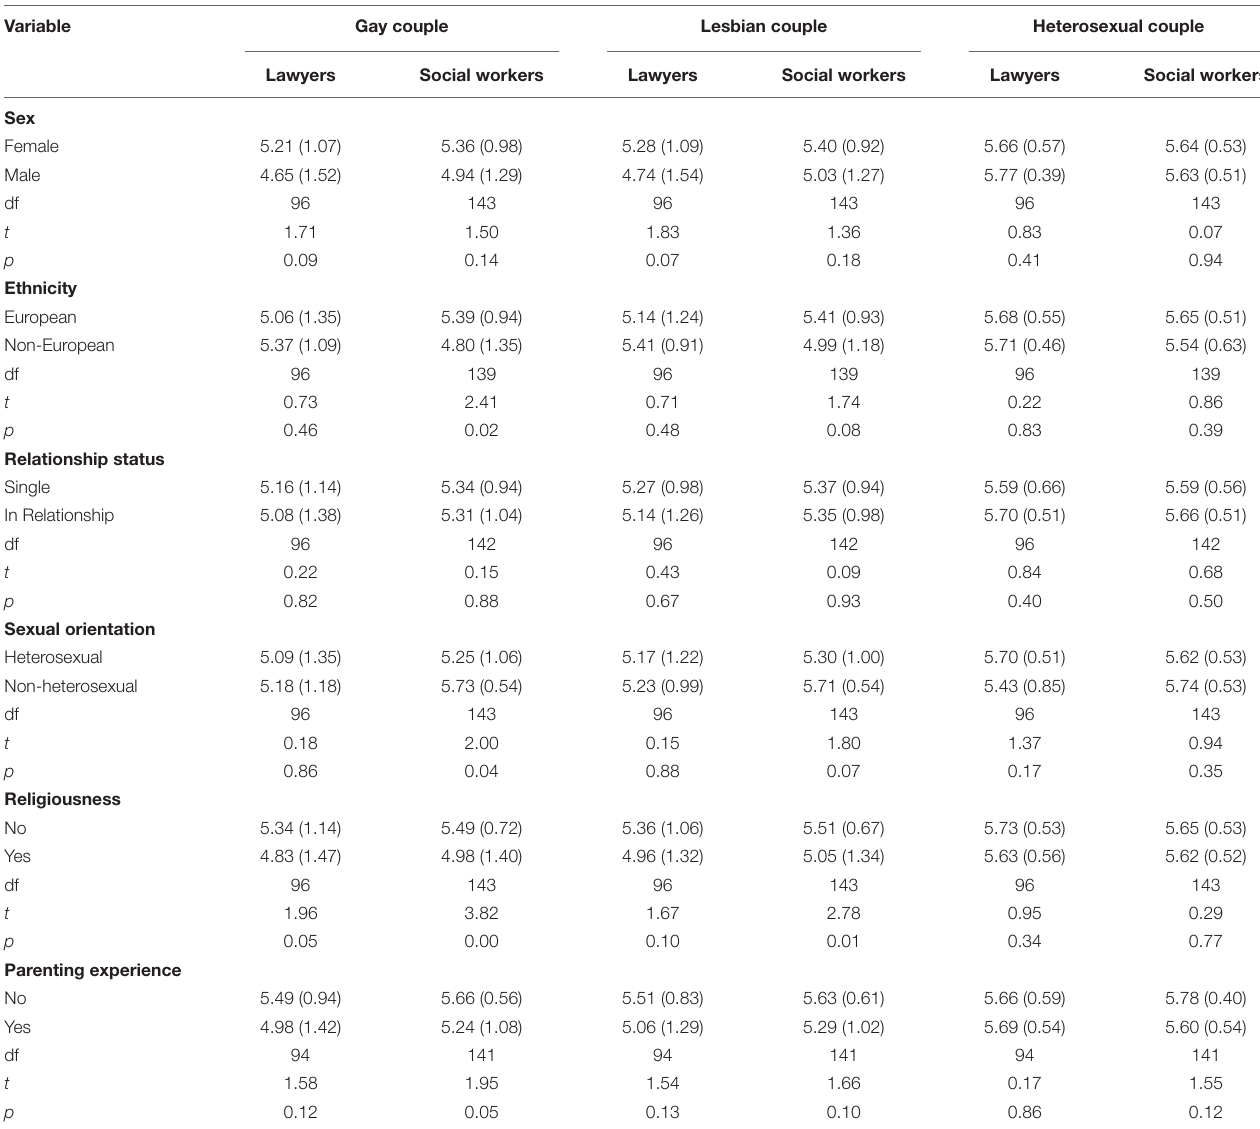
TABLE 5 | Participants’ background characteristics and means (SD) of their perceptions on the suitability for children with different characteristics to be adopted by gay, lesbian and heterosexual couples ( N = 243). Variable Gay couple Lesbian